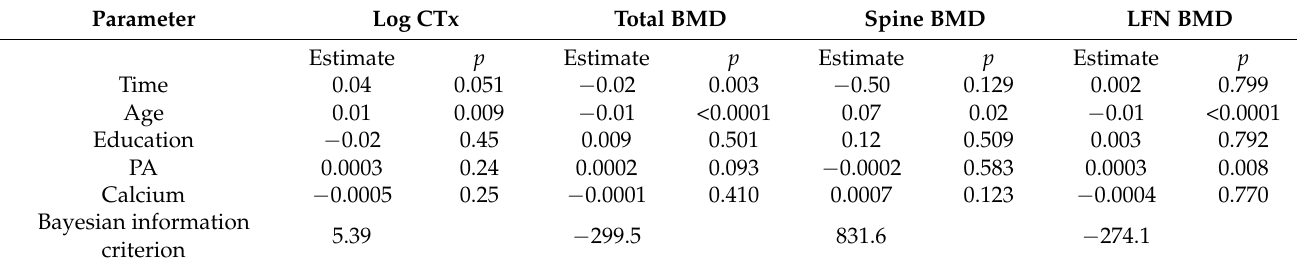
Table 3. The association between bone health variable and lifestyle and dietary factors (linear mixed models).